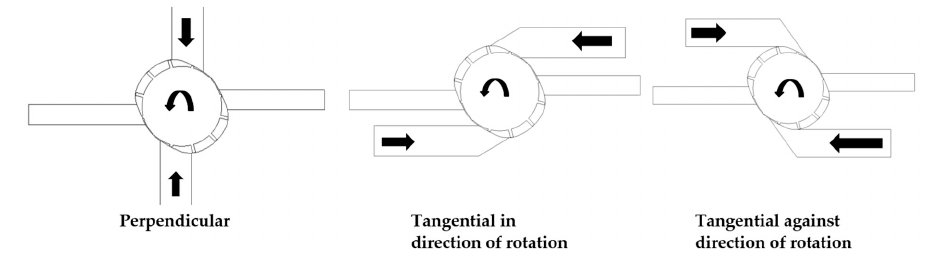
Figure 21. Overview of the analyzed suction port configurations.